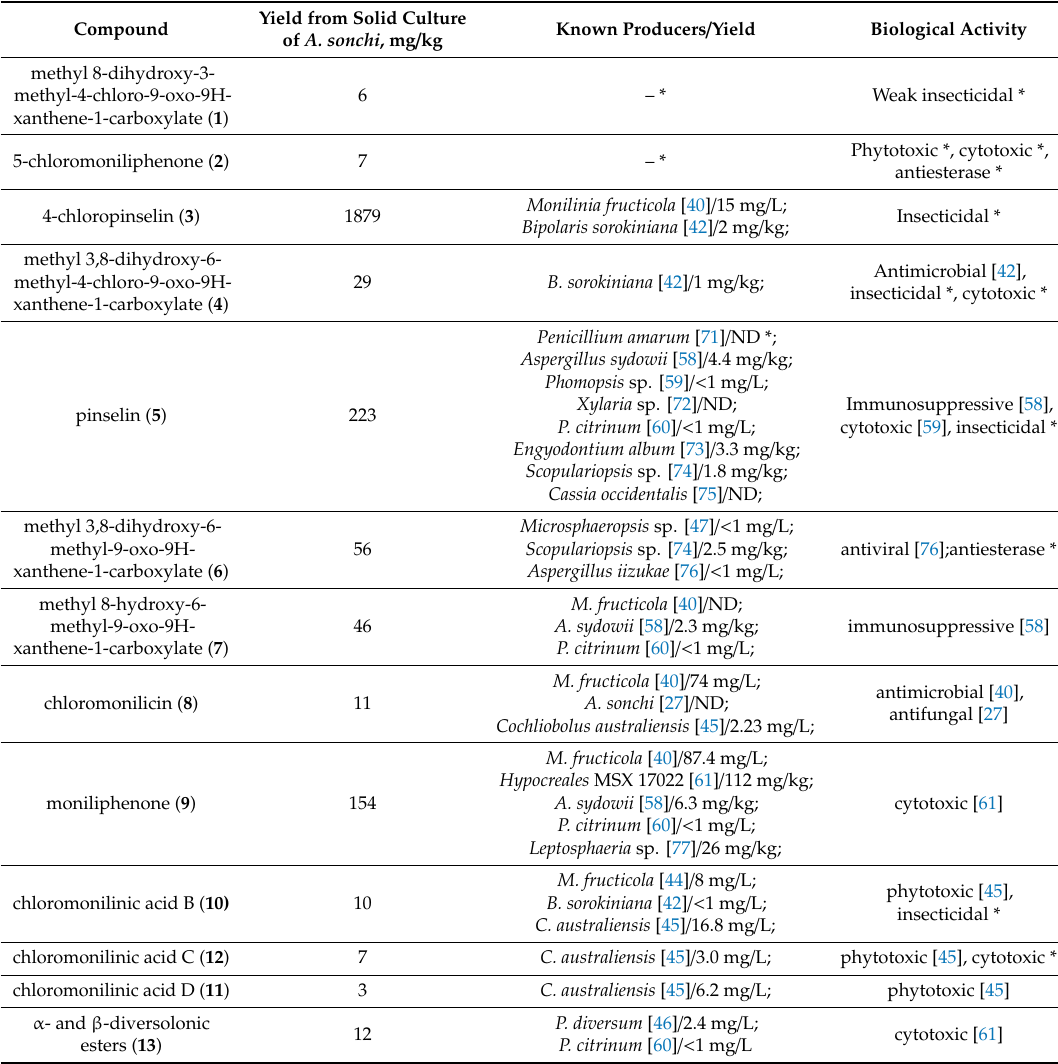
Table 6. The yield and biological activity of A. sonchi